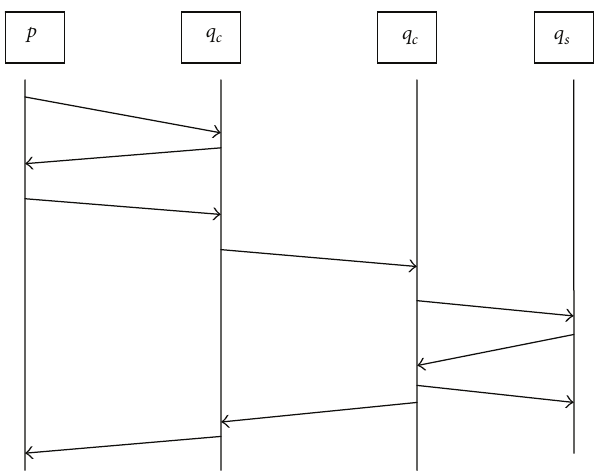
Figure 2: The two-end handshake